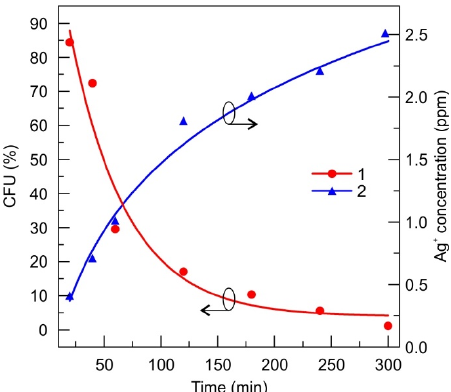
Figure 2. Number of colony-forming units (CFUs), normalized to the control sample, indicating antimicrobial properties of the RF oxygen plasma-processed DLC:Ag film on silk soaked in the bacterial solution (1) and the corresponding evolution of silver ion concentration in time (2). The 0.5 Mf of S. aureus bacteria suspension was diluted 10 − 5 and the and active contact surface of the cloth was 6 cm 2 / mL. The curves were fitted with the exponential (1) and logarithmic (2) functions. The fit parameters are summarized in Supplementary Table